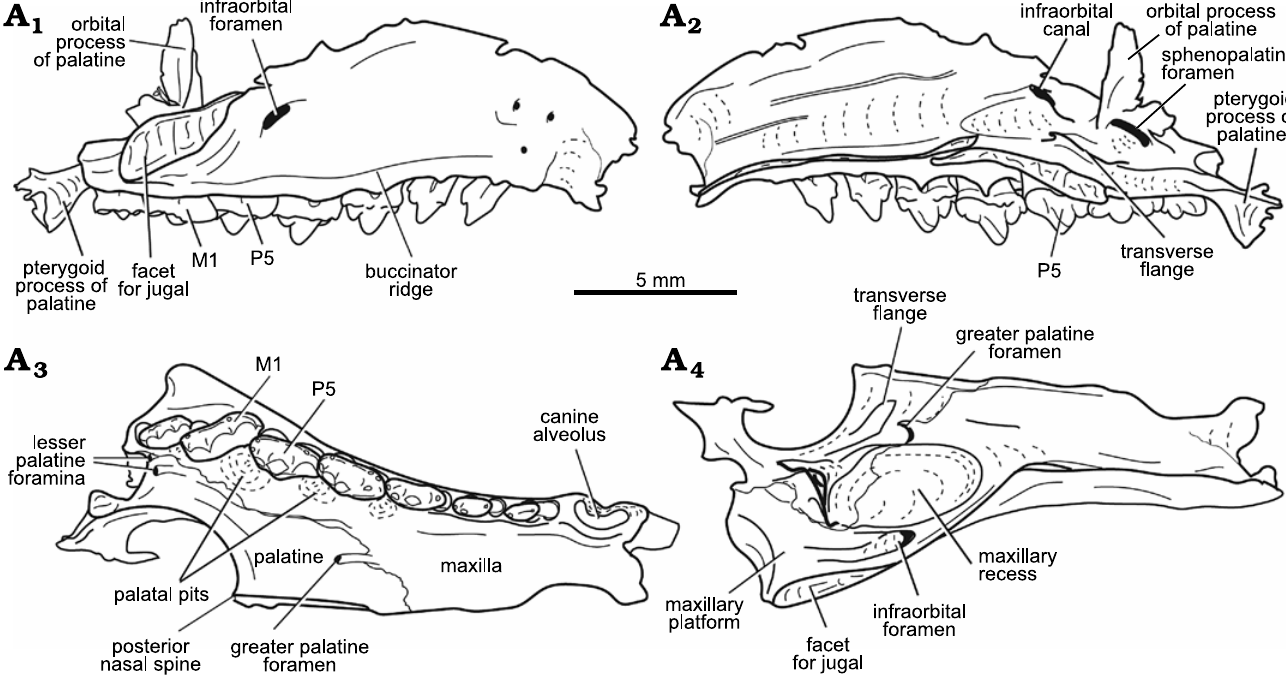
Fig. 4. Illustration of the morganucodontan mammaliaform Cifellilestes ciscoensis gen. et sp. nov. (OMNH 80538, holotype); right skull fragment in lateral (A 1 ), medial (A 2 ), ventral (A 3 ), and dorsal (A 4 )